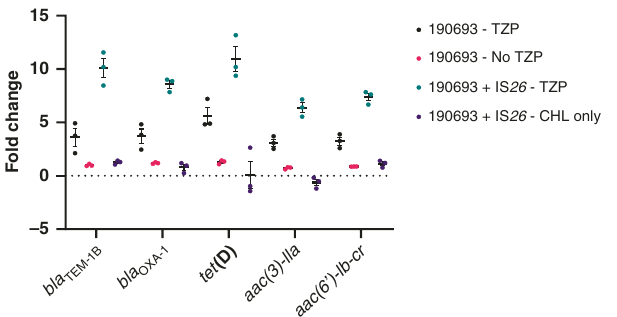
Fig. 3 Copy number of antimicrobial resistance genes present on the translocatable unit increased following in vitro replication of the evolutionary event leading to piperacillin/tazobactam resistance. Fold change in copy number of all the antimicrobial resistance genes found on the pseudo-compound transposon compared to the housekeeping gene uidA following growth of the piperacillin/tazobactam (TZP)-susceptible isolate in the absence of antibiotics (pink circles), TZP-susceptible isolate in the presence of 8/4 µ g/ml TZP (black circles), TZP-susceptible isolate transformed with pHSG396 plasmid containing IS 26 in the presence of 8/4 µ g/ml TZP and 35 µ g/ml chloramphenicol (green circles) and TZP- susceptible isolate transformed with pHSG396 plasmid containing IS 26 in the presence of 35 µ g/ml chloramphenicol only (purple circles). All error bars represent the standard error of the mean ( n = 3). Source data are provided as a Source Data fi le. and 1385 bp (right) products (Fig. 2d), consistent with the insertion of the TU adjacent to IS 26 and reforming PTn 6762 in pHSG396